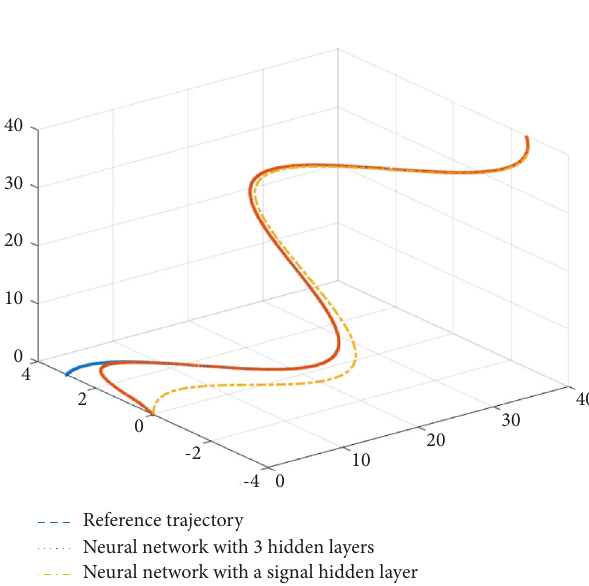
Figure 6: Tracking the reference trajectory with different hidden layers neural network.